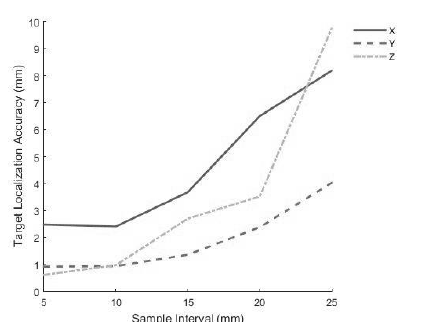
Figure 6. Relationship between the sample intervals and the accuracy of target localization using Cyclone